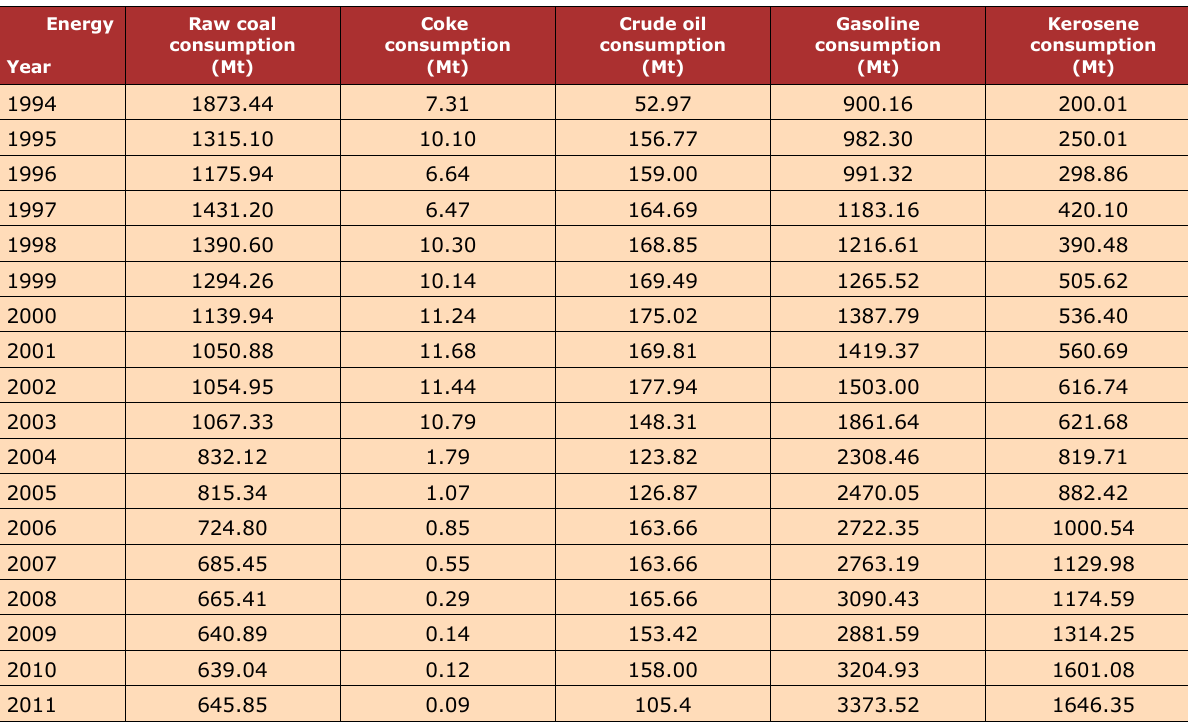
Table 2(a). Energy Consumption and Carbon Emissions of China’s Transportation Industry